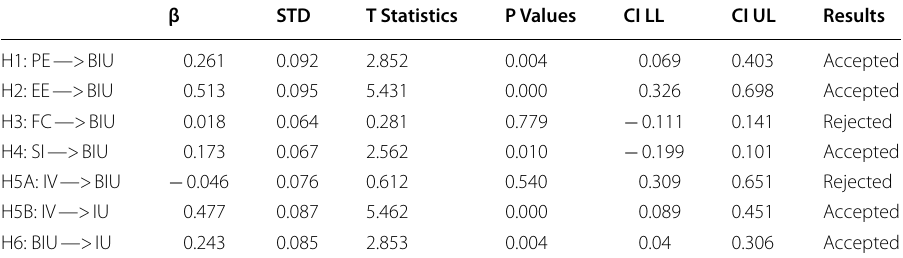
Table 6 Summary of hypotheses testing β STD T Statistics P Values CI LL CI UL